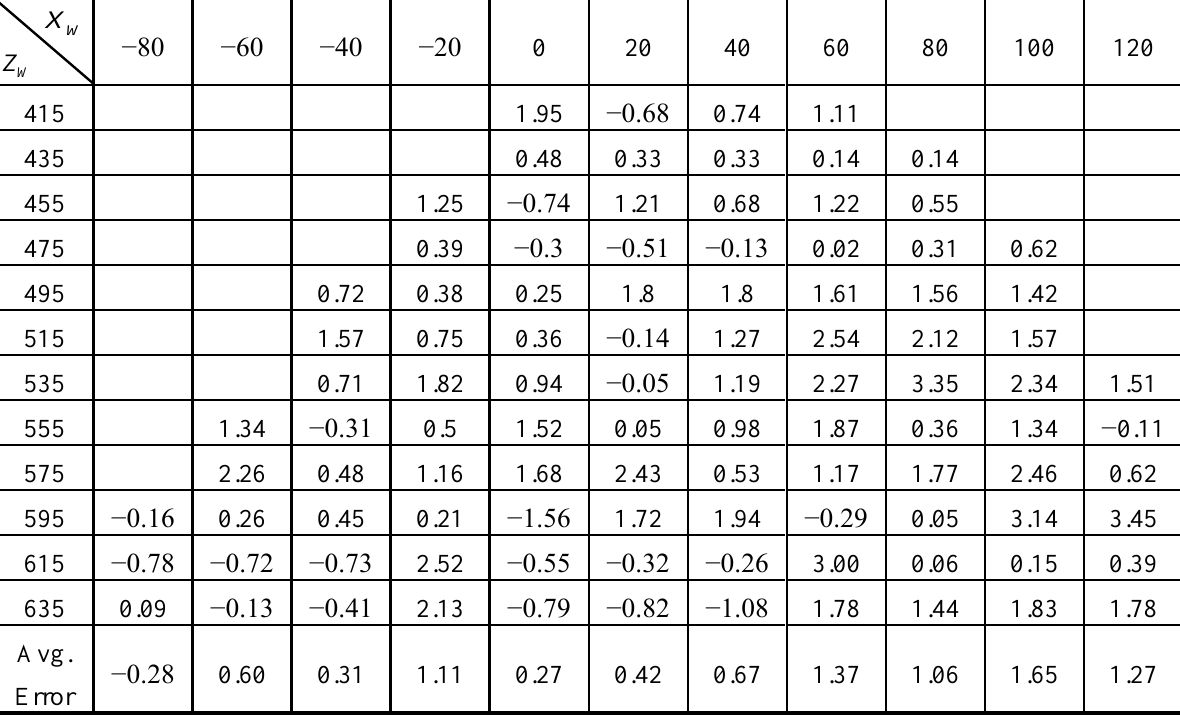
Table 4. Depth ( Z ) measurement error after correction (unit: W